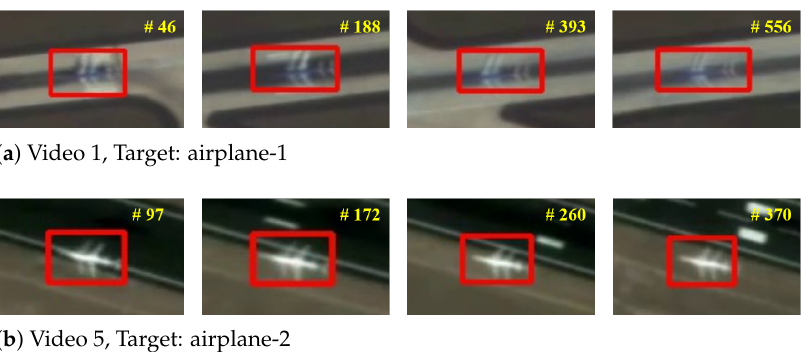
Figure 10. ID-DSN still maintains relatively accurate tracking results in the case of residual shadow.